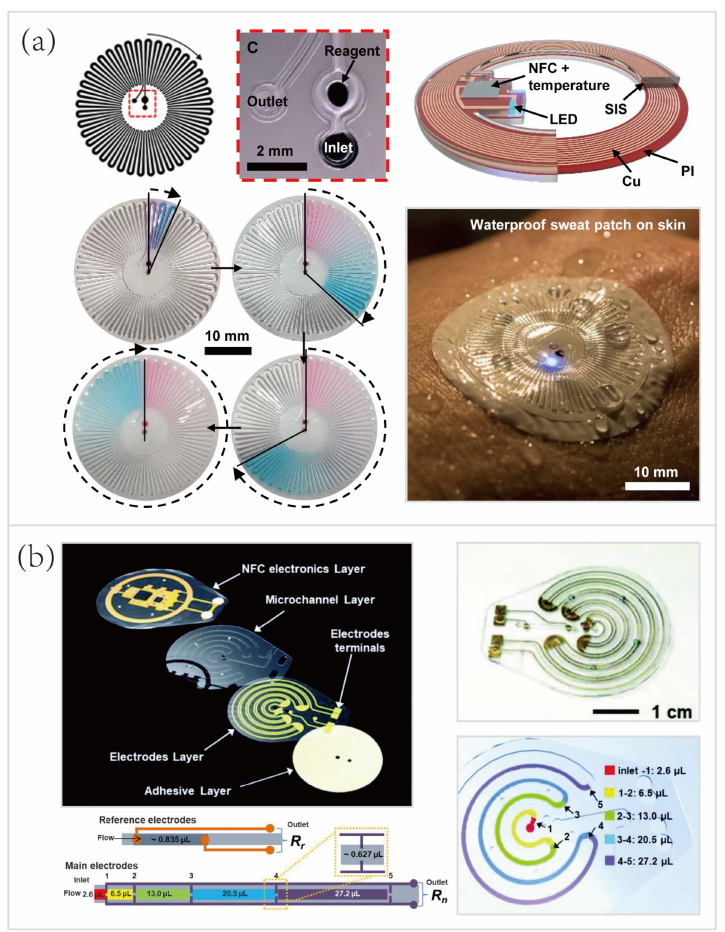
Figure 9. Wearable biosensors for sweat volumetry. ( a ) A waterproof skin-interfaced microfluidic biosensor for volumetric sensing, biomarker analysis, and thermography in aquatic settings; images showing the special inlet and outlet pores, as well as the volumetric sensing by using red / blue dyes to facilitate the visual inspection [33]. Copyright 2019, American Association for Advancement of composition; illustrations showing the volumes of microfluidic channels that lay between di ff erent pairs of probing pads [27]. Copyright 2018,